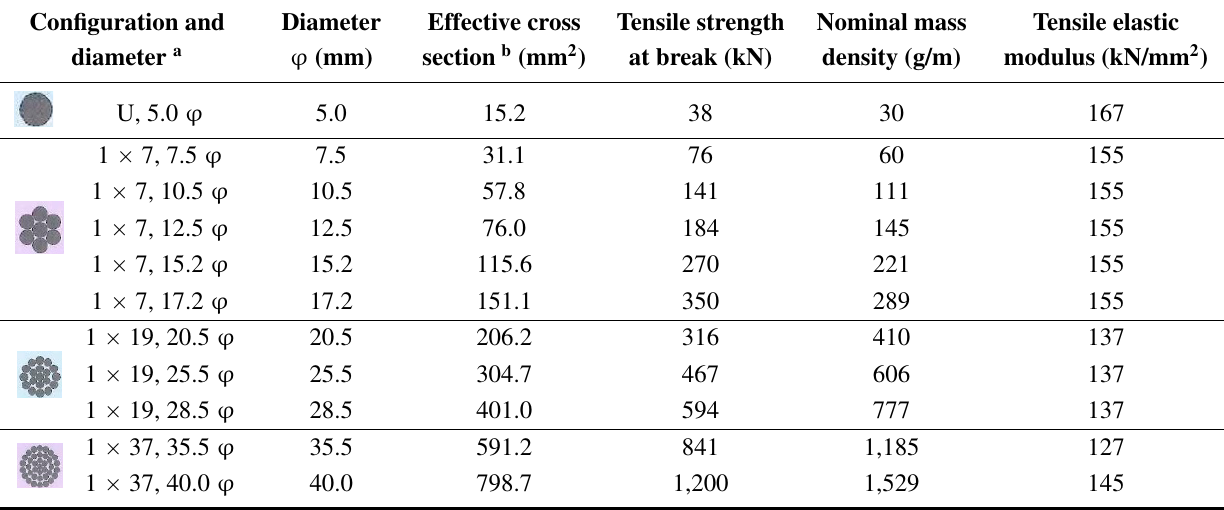
Table 1. Specification of the standard CFCC cables.